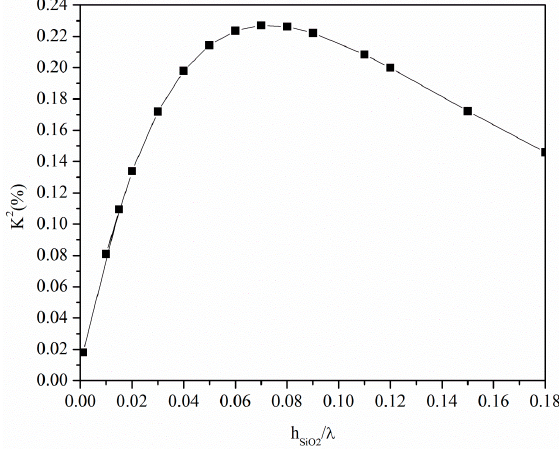
Figure 5. The K 2 of the ST-Y quartz vs . the SiO 2 normalized thickness.